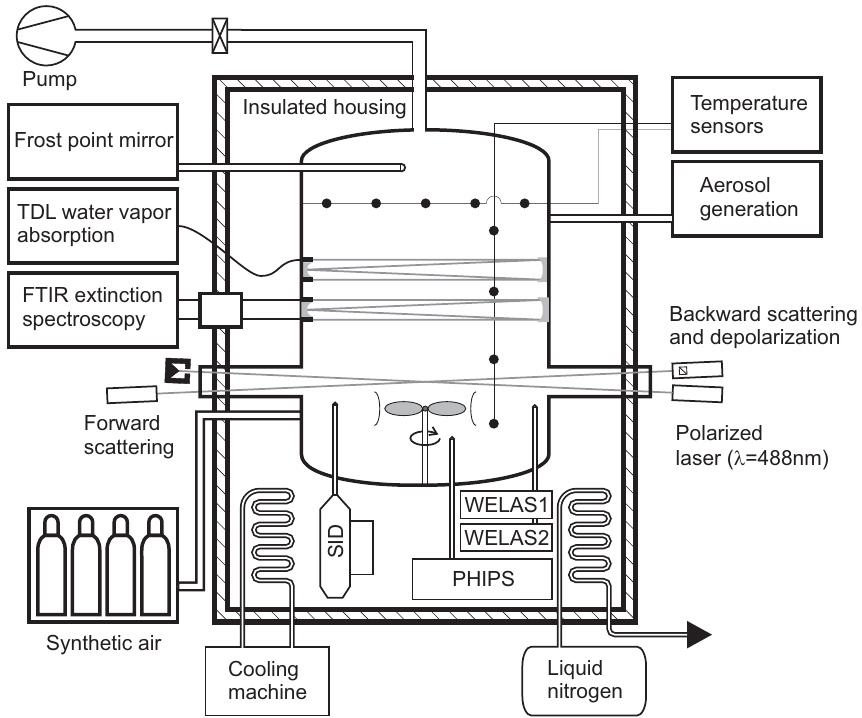
Fig. 5. Scheme of the aerosol and cloud simulation chamber AIDA including the instrumentation used in the present